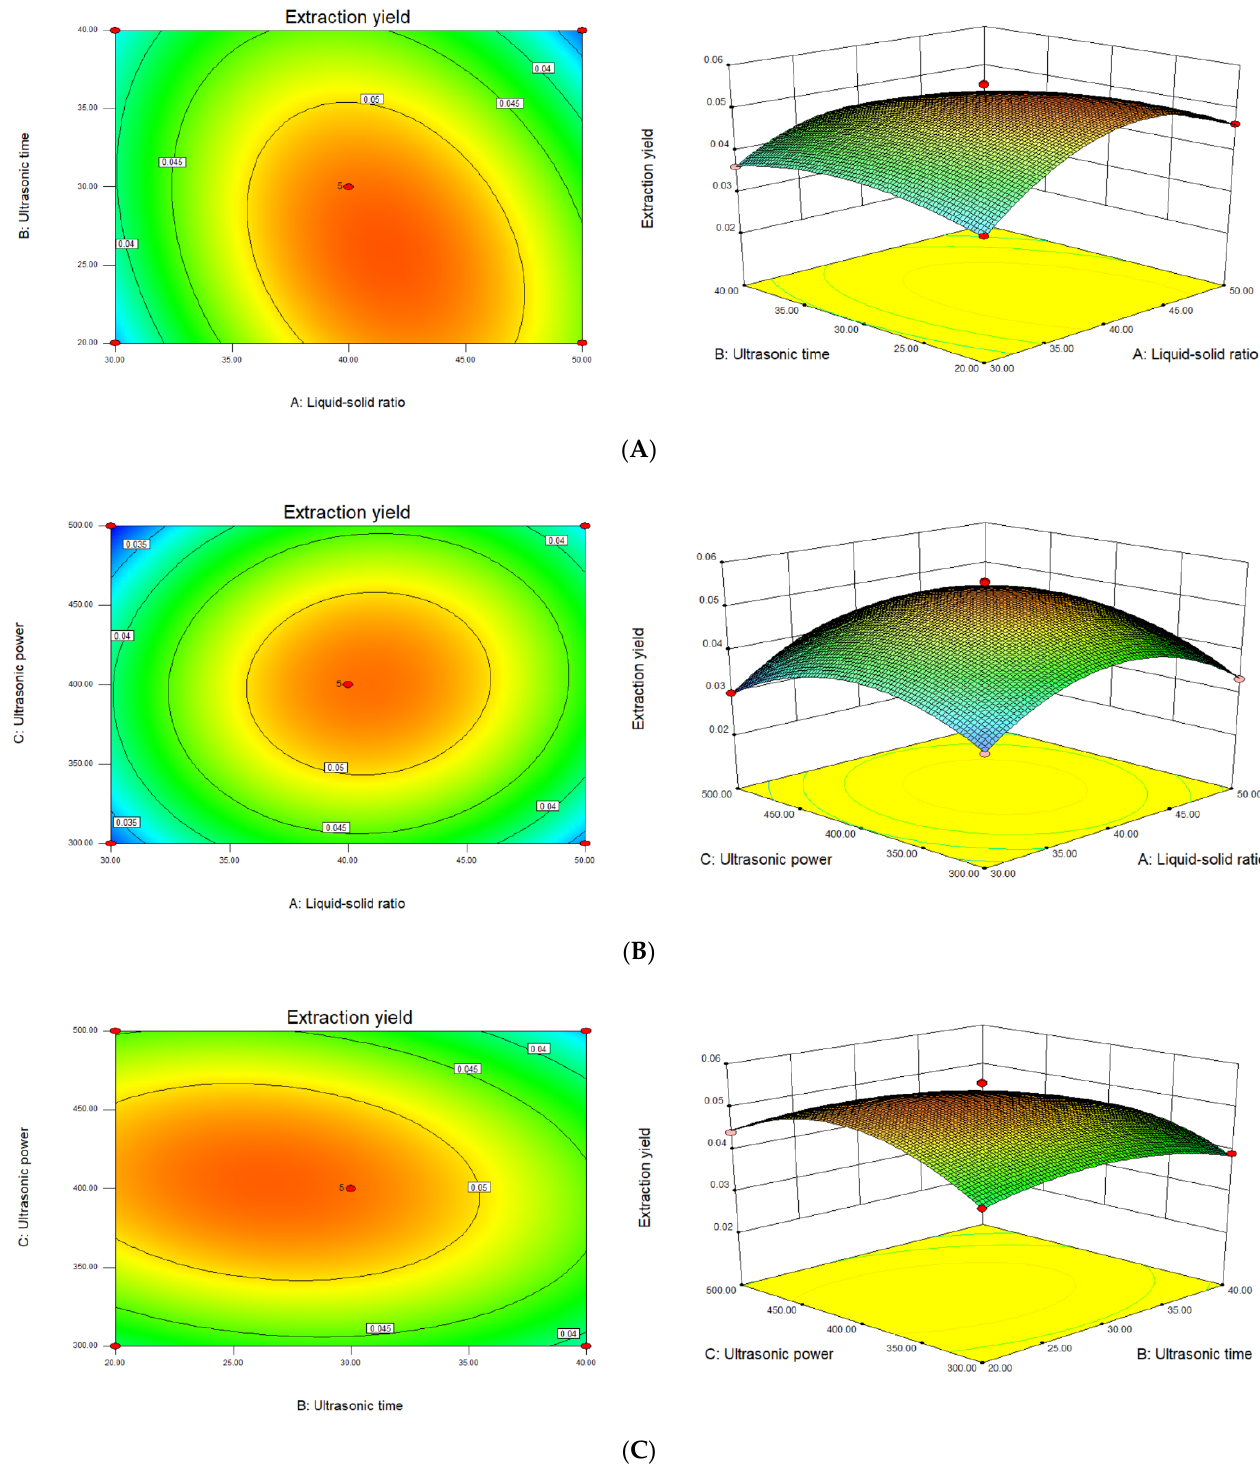
Figure 2. Contour plots and response-surface plots of the interactive effects of different factors on the DNP yield, ( A ) liquid–solid ratio and ultrasonic time, ( B ) liquid–solid ratio and ultrasonic power, and ( C ) ultrasonic time and ultrasonic power.